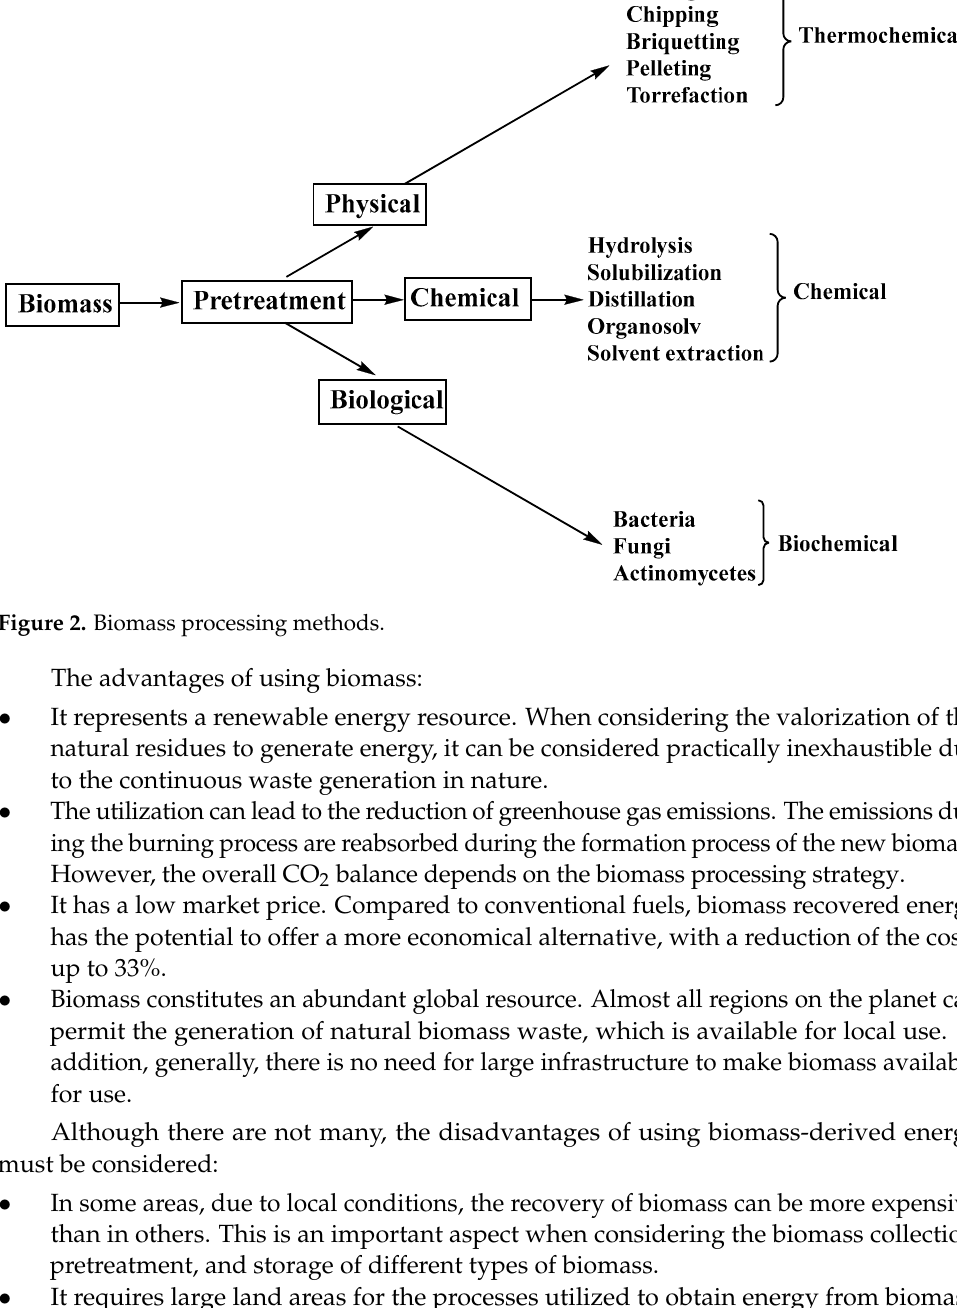
Figure 1. The most important biomass sources (adapted from [2] ).